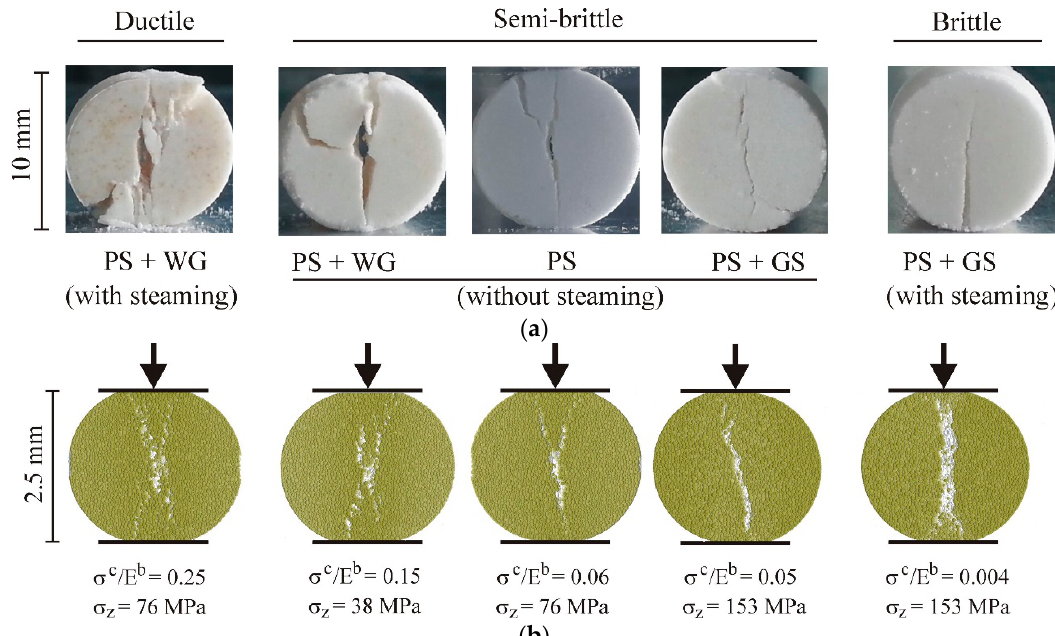
Figure 10. Profiles of the ductile, semi-brittle, and brittle breakage modes: ( a ) experimental and ( b ) simulated for σ c = 10 MPa.